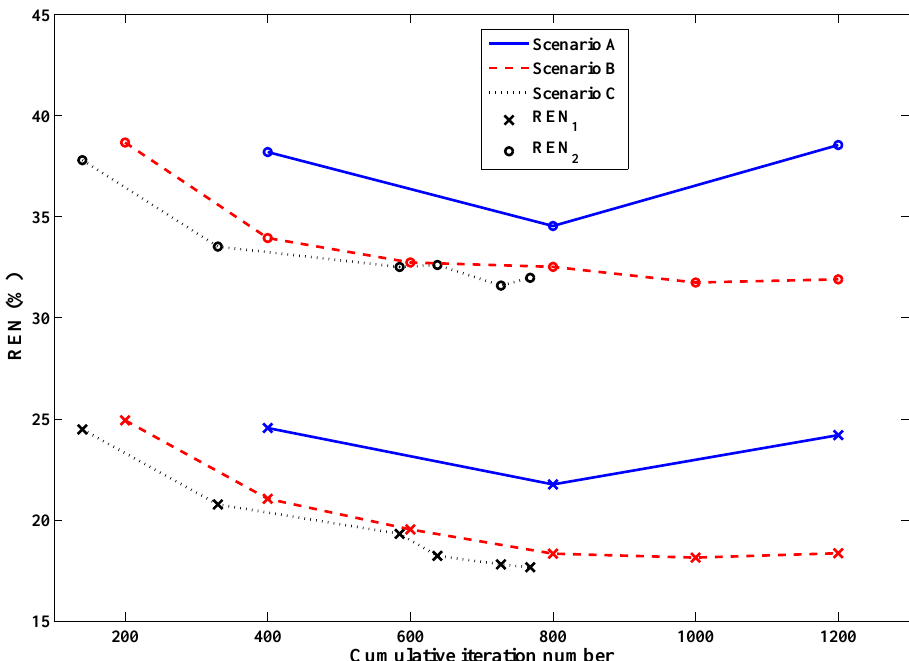
Figure 7. Relative error norms of frequency-hopping and frequency-cycled reconstructions: Scenario A (solid line)—without tissue-dependent mapping at 400 iterations per frequency terminating after first inversion of 3.0 GHz, Scenario B (dashed line)—with tissue-dependent mapping at 200 iterations per frequency, cycling through reconstruction frequencies once (with imaginary component “anchored” following initial 1.0 GHz inversion), Scenario C (dotted line)—with tissue-dependent mapping and stopping criteria in place, terminating after two consecutive inversions of 1.0 GHz data (one with the imaginary component “anchored” and the final run with the imaginary component freely optimized according to the guidelines of Section 2.5). See Table 1 for further details. Table 1. Reconstruction progression of open boundary scenarios (Figure 7).